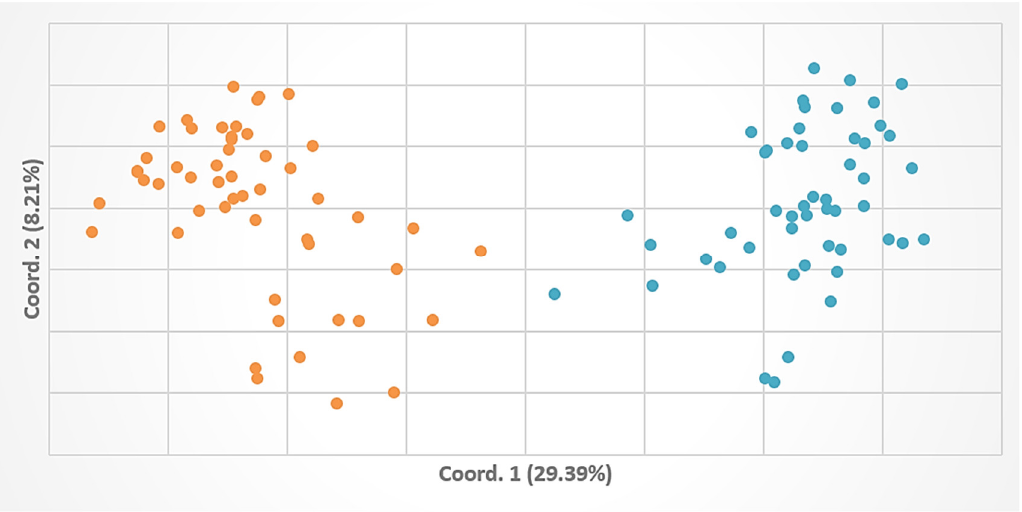
Figure 5. Principal Coordinates Analysis using the selected ISSR markers from 102 individuals (in orange— Pâclele Mari individuals, in blue— Pâclele Mici individuals).